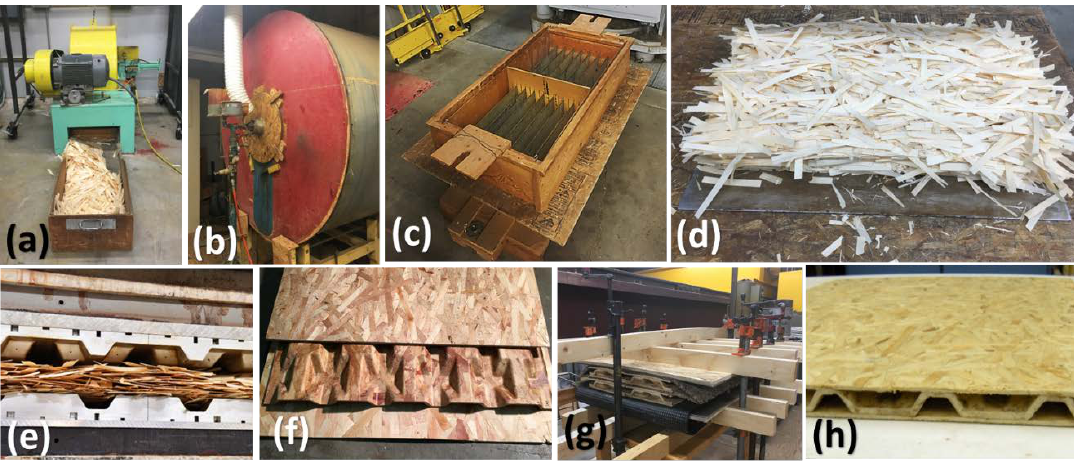
Figure 1. Fabrication process: ( a ) disc-strander, ( b ) blender, ( c ) orientor, ( d ) preform, ( e ) hot-pressing using mold, ( f ) components of sandwich panel, ( g ) clamped panels, and ( h ) sandwich panel.